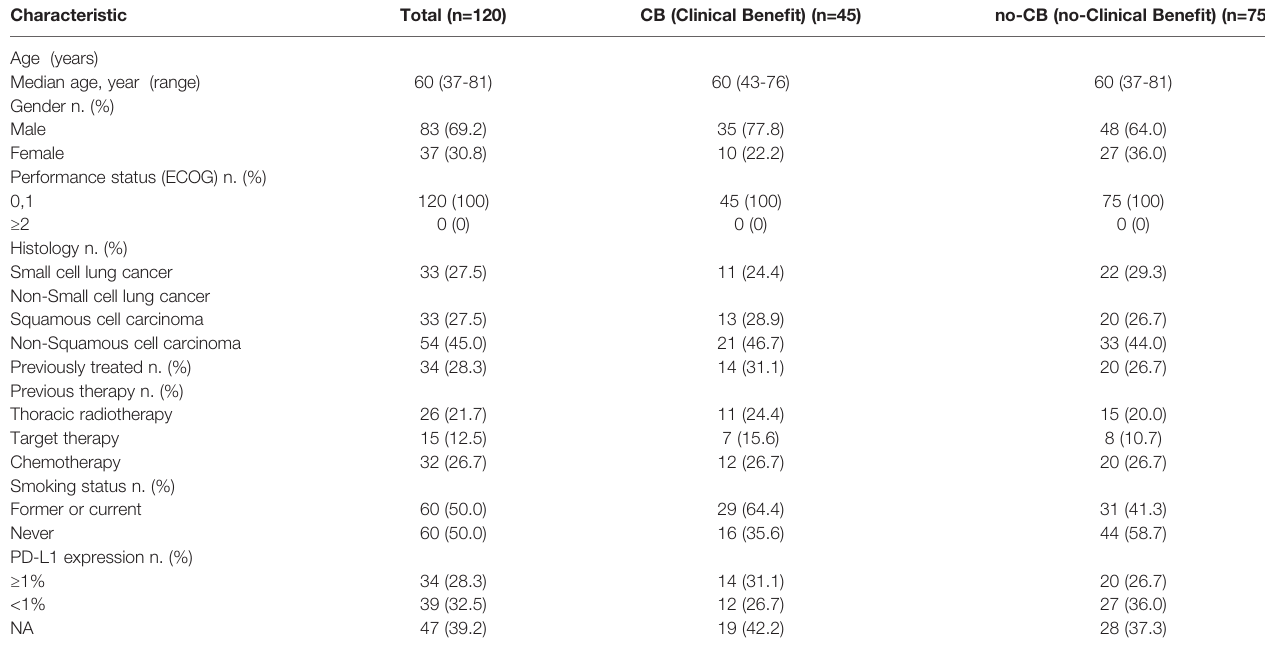
TABLE 1 | Baseline characteristics of all 120 patients.